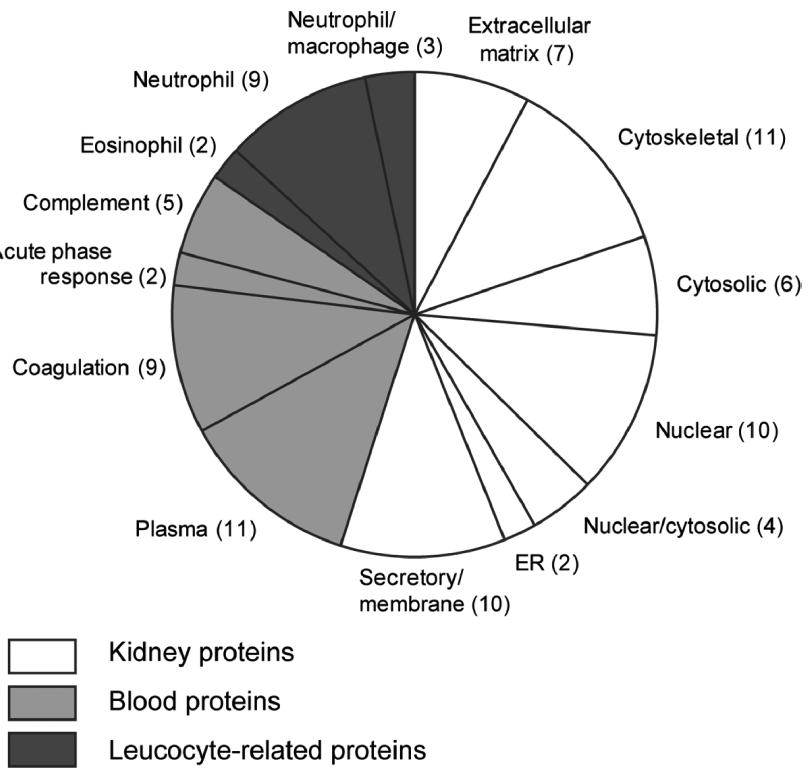
Figure 4. Classification of protein components detected in CaOx kidney stones. Extracts from 9 individual CaOx stone samples were examined separately by shotgun analysis as shown in Fig. 3, and the results in detail were presented in Table S1. As summarized in this figure, a total of 92 proteins were identified in this analysis. These proteins could be classified into three major groups according to their possible origins, i. e., kidney proteins, blood proteins and leucocyte-related proteins. Proteins in each group were further classified into subgroups.